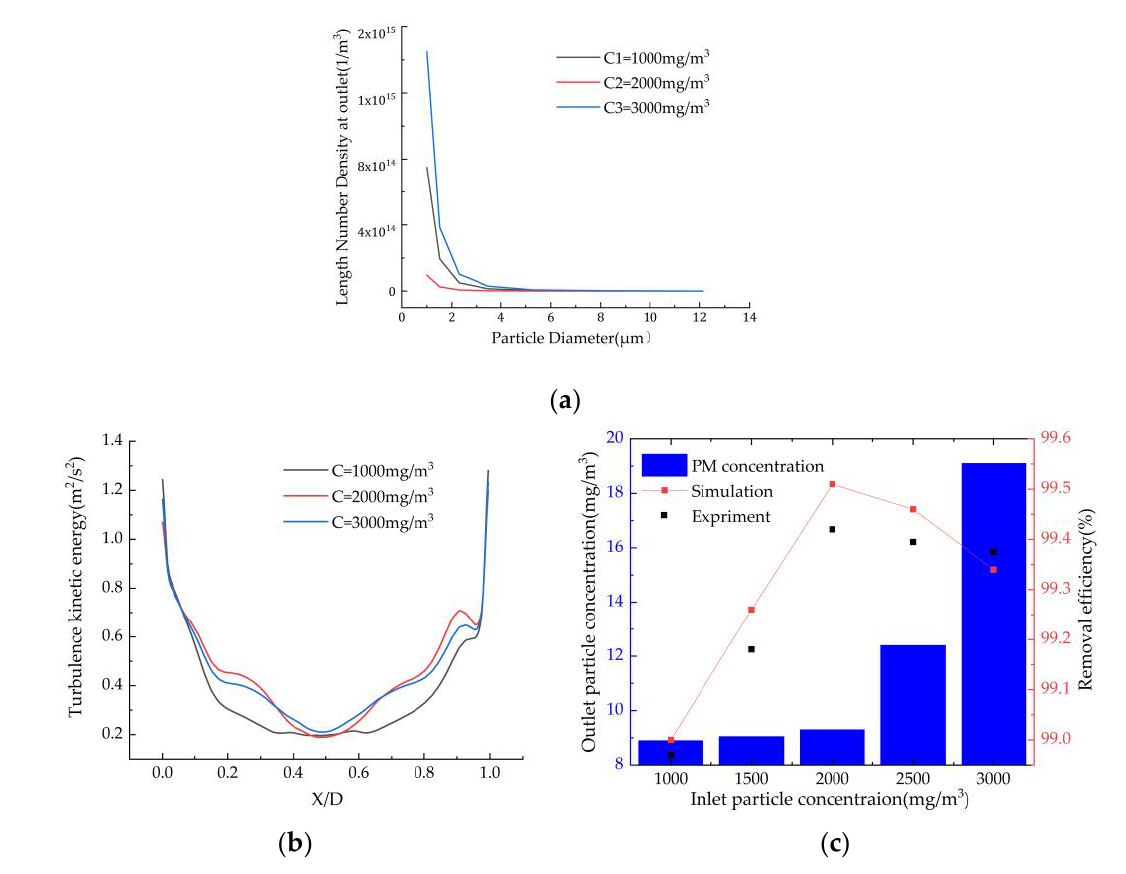
Figure 8. Effect of the particle concentrations on the ( a ) particle number density, ( b ) turbulent kinetic energy at Z = 850 mm, and ( c ) particle concentration and removal efficiency.